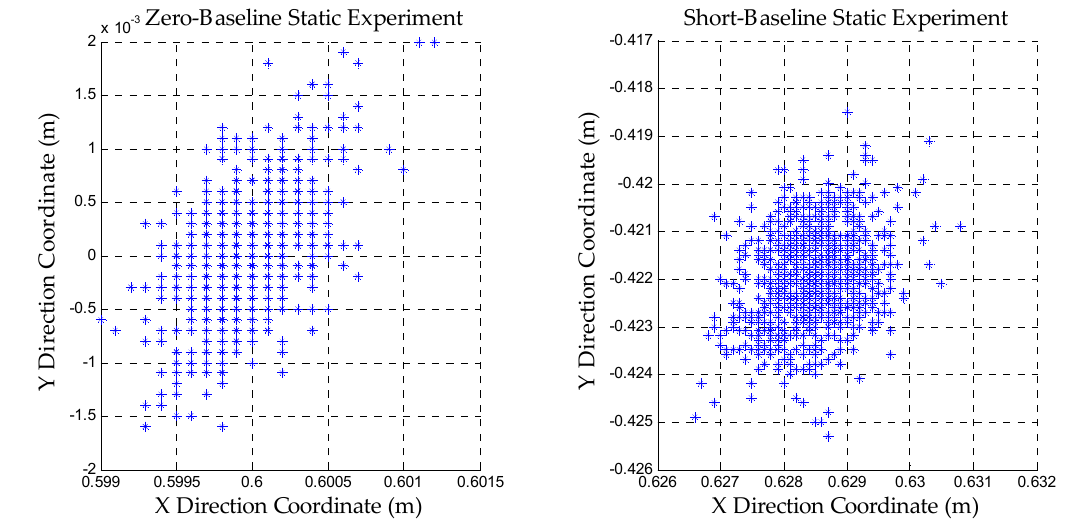
Figure 8. Results of static experiments after the ambiguities are fixed.